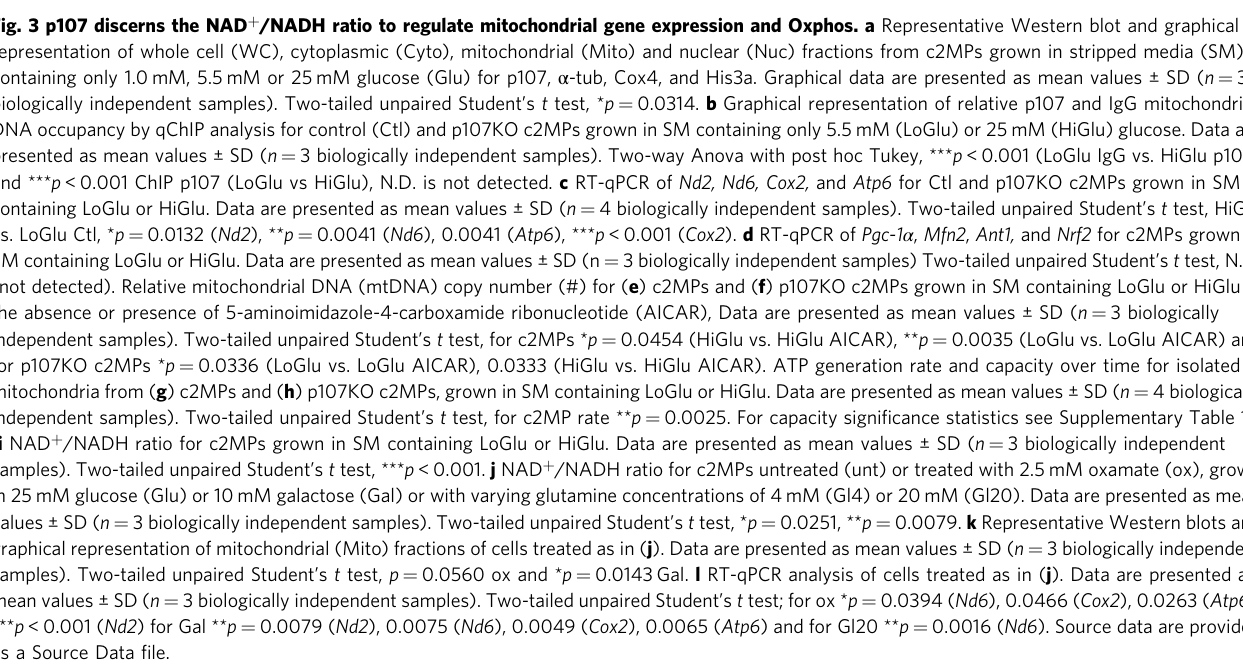
Fig. 3 p107 discerns the NAD + /NADH ratio to regulate mitochondrial gene expression and Oxphos. a Representative Western blot and graphical representation of whole cell (WC), cytoplasmic (Cyto), mitochondrial (Mito) and nuclear (Nuc) fractions from c2MPs grown in stripped media (SM) containing only 1.0 mM, 5.5 mM or 25 mM glucose (Glu) for p107, α -tub, Cox4, and His3a. Graphical data are presented as mean values ± SD ( n = 3 biologically independent samples). Two-tailed unpaired Student ’ s t test, * p = 0.0314. b Graphical representation of relative p107 and IgG mitochondrial DNA occupancy by qChIP analysis for control (Ctl) and p107KO c2MPs grown in SM containing only 5.5 mM (LoGlu) or 25 mM (HiGlu) glucose. Data are presented as mean values ± SD ( n = 3 biologically independent samples). Two-way Anova with post hoc Tukey, *** p < 0.001 (LoGlu IgG vs. HiGlu